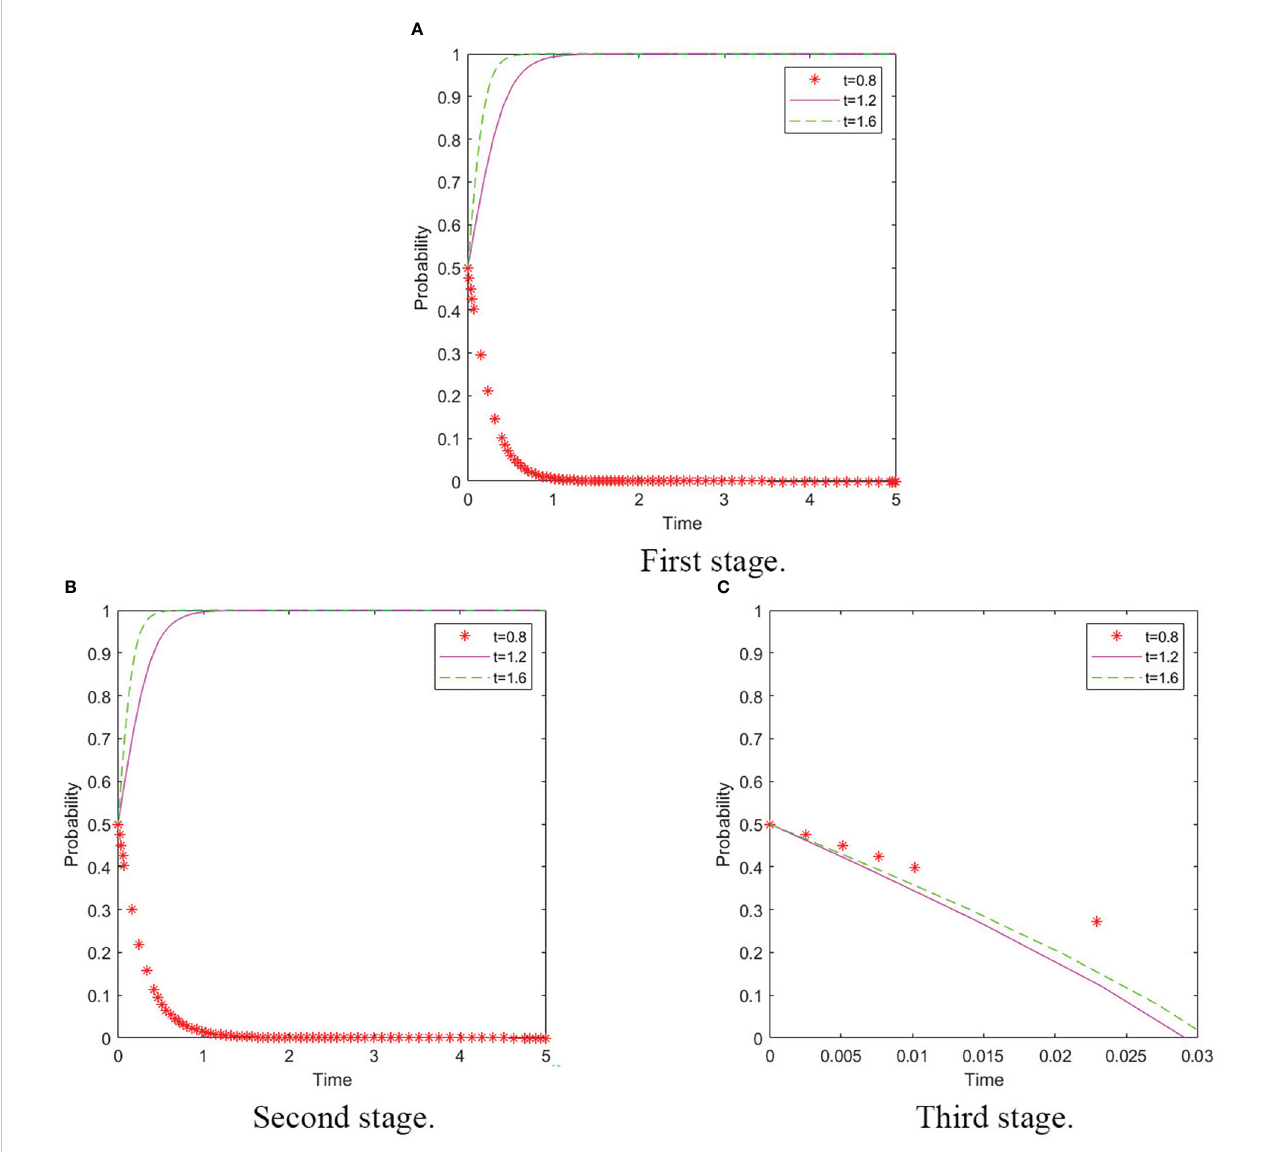
FIGURE 7 Changing the evolutionary path of the technological improvement coef fi